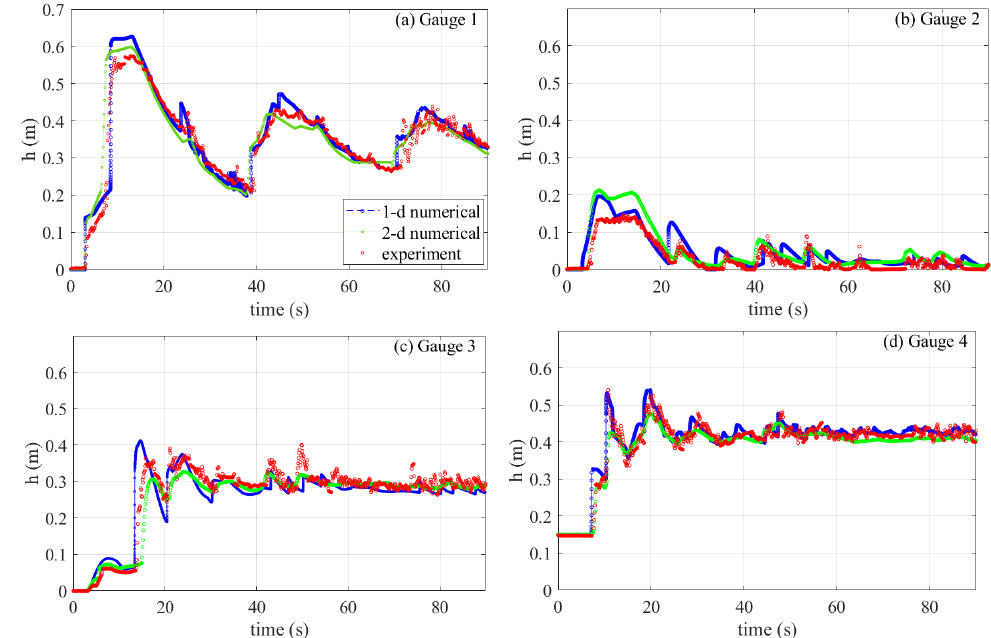
Figure 10. Water levels at four wave gauges, showing the comparison between the MCS-scheme (blue), experiments [3] (green), and 2d-numerical results [17]